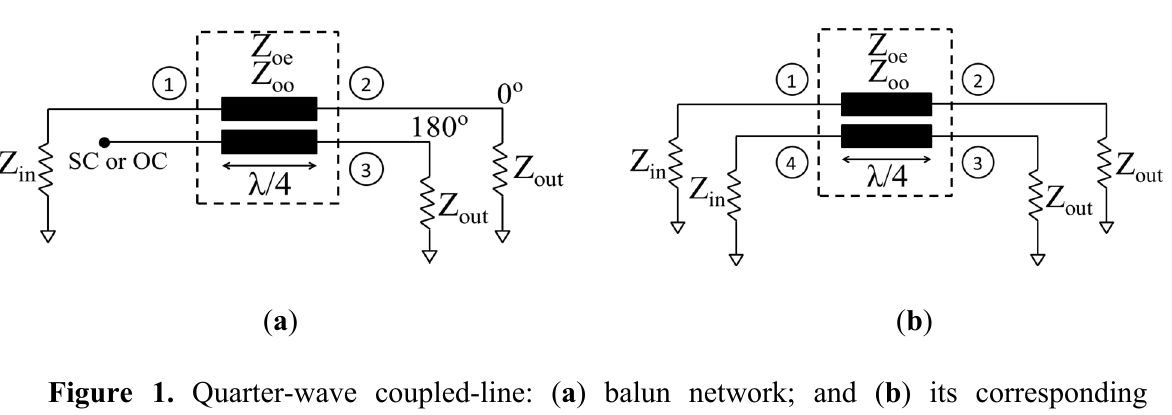
Figure 1. Quarter-wave coupled-line: ( a ) balun network; and ( b ) its corresponding four-port network for odd- and even-mode